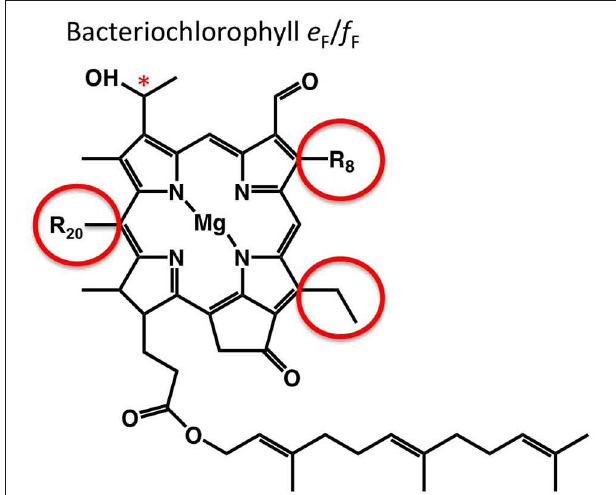
FIGURE 1 | The structure of BChl e F and f F . For both BChls, the C-12 side chain is an ethyl group (lower right circle); the R 8 side chains may be ethyl, propionyl, isobutyl, or neopentyl (upper right circle); and the C-3 1 carbon may have R or S stereochemistry (asterisk). For BChl e F , the R 20 side chain is a methyl group; for BChl f F , the R 20 side chain is a